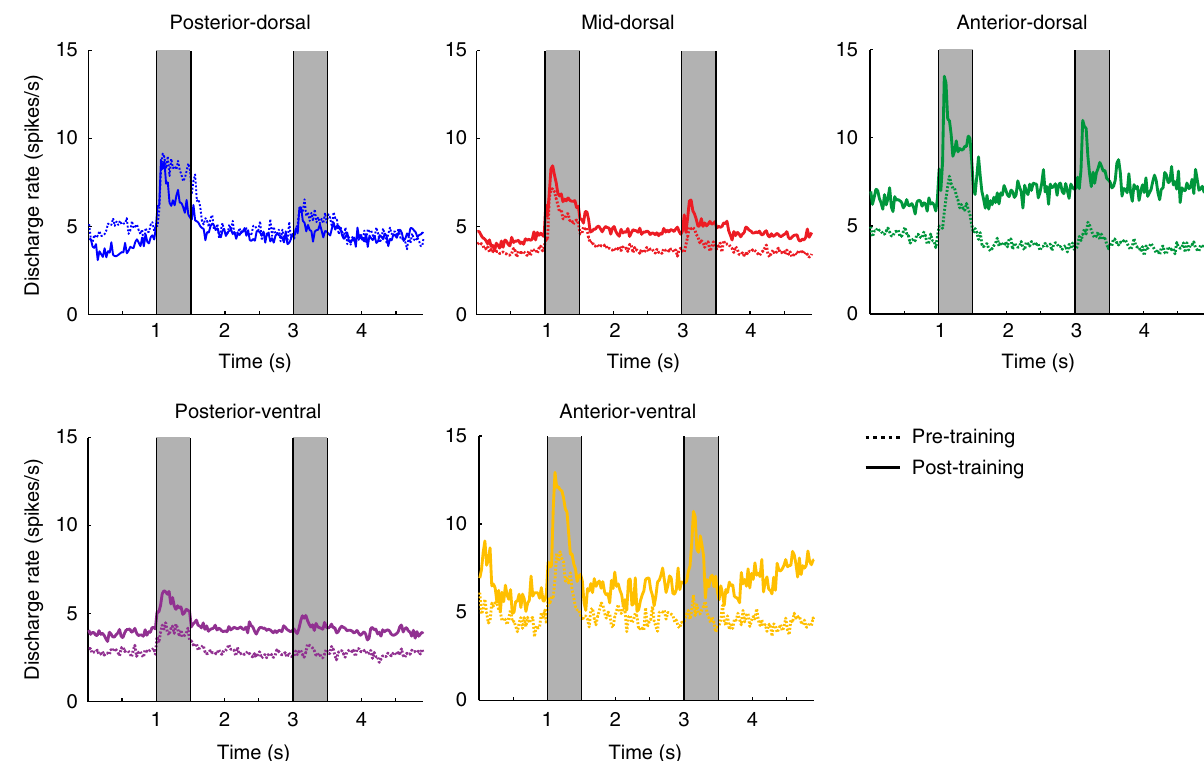
Fig. 2 Firing rate changes after training. Peri-stimulus Time Histogram depicting mean fi ring rate during the trial, based on each neuron ’ s best cue location, before and after training. Time 0 represents the onset of the fi xation point. The cue stimulus is presented between 1.0 – 1.5 s (gray bar). Data are shown separately for each prefrontal region (Posterior-dorsal: Pre-training/post-training n = 175/204 neurons; Mid-dorsal n = 668/659; Anterior-dorsal n = 298/212; Posterior-ventral n = 502/581; Anterior-ventral n = 92/117)